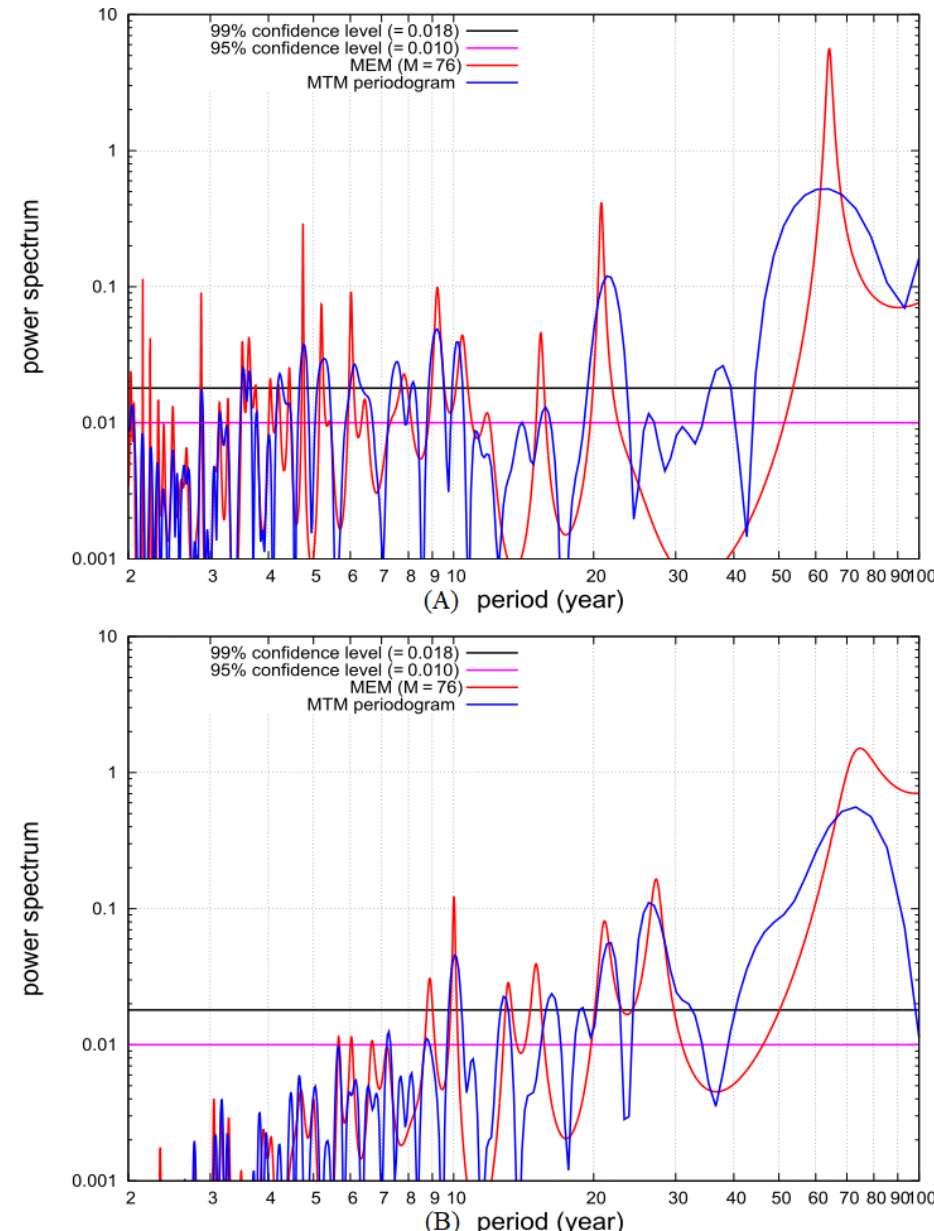
Figure 3. Power spectra of the global surface temperature record ( A ) and the CMIP5 multi-model mean function ( B ). The power spectra are calculated using the Multi-Taper Method (MTM) and the Maximum Entropy Method (MEM) using the SSA-MTM toolkit for spectral analysis [118,119]. The 95% and 99% confidence levels are deduced from the analysis of the theoretical temperature error analyzed in Figure